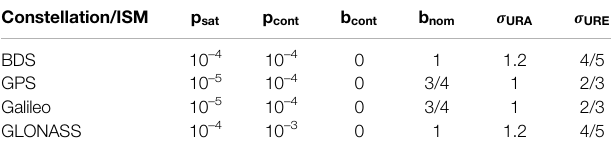
TABLE 3 | ISM parameter settings of each constellation. Constellation/ISM